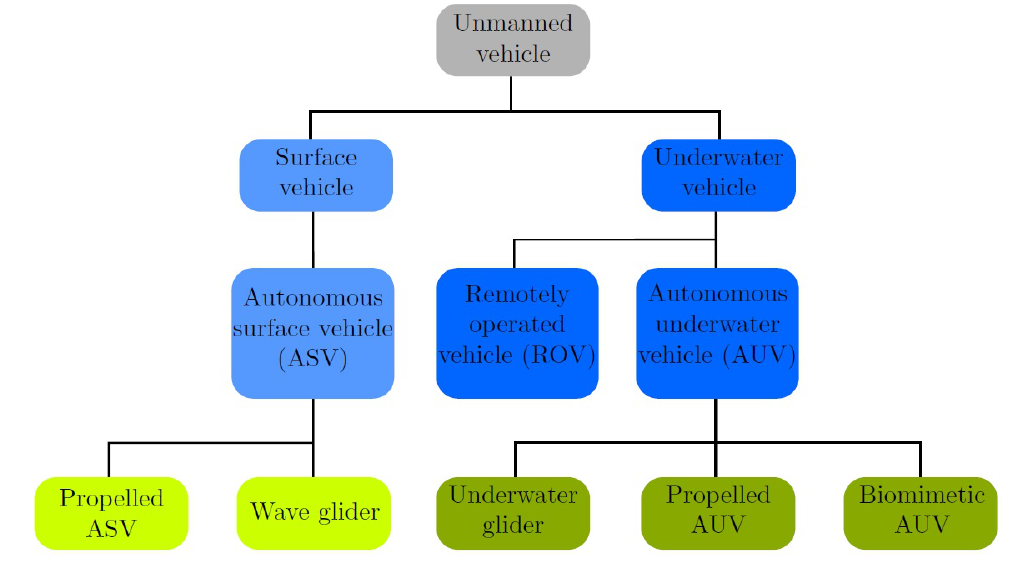
Figure 1. Underwater vehicles’